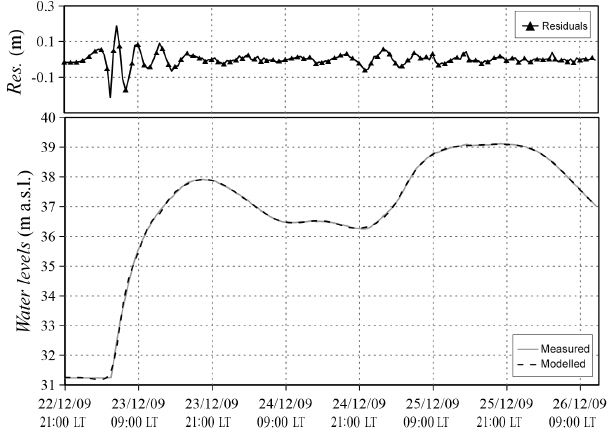
Figure 17. Secchia 2009 event: observed and modelled water levels in section B. The residuals between recorded and estimated values are also